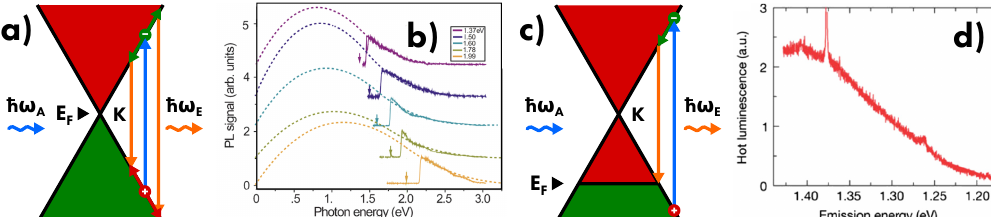
Figure 12. ( a ) Diagram and ( b ) spectra of photoluminescence thermalized electrons in graphene. Reprinted with permission from Ref. [50]. Copyright (2017) American Chemical Society. ( c ) Diagram and ( d ) spectra of photoluminescence non-thermalized electrons in graphene. Reprinted with permission from Ref. [22]. Copyright (2012) Elsevier.